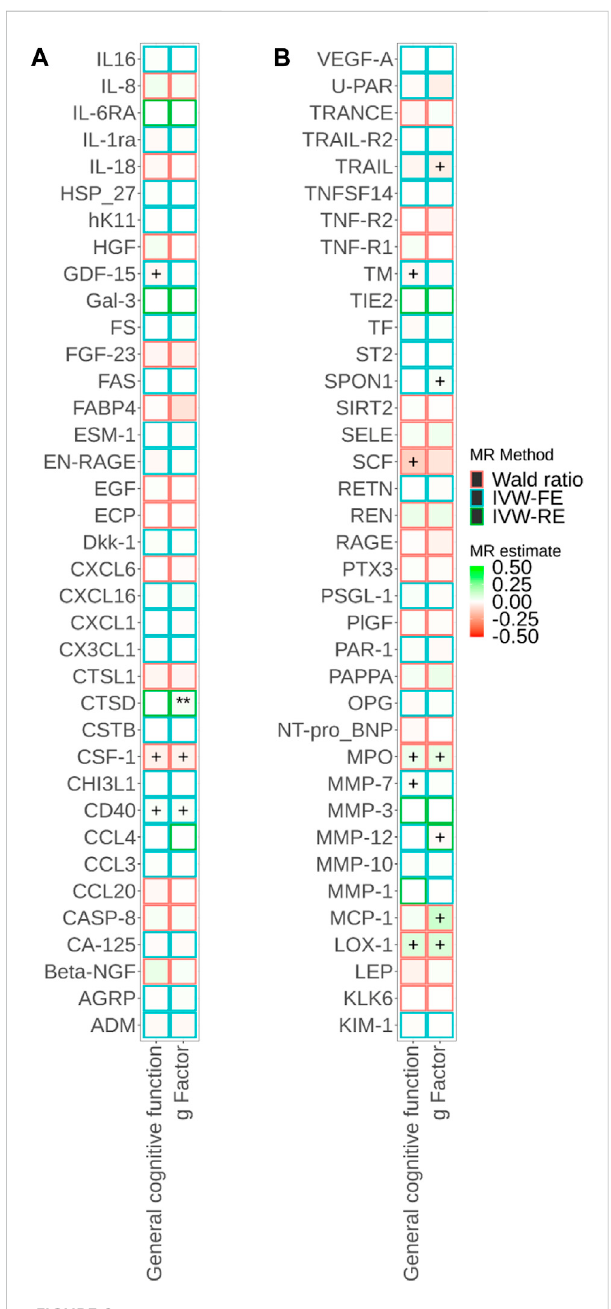
FIGURE 2 Associations of cis-pQTL-predicted plasma protein concentrations with cognitive traits from Mendelian randomisation (MR).MRestimatewasobtainedfromtheWaldratiomethod(N SNP =1) and inverse-variance weighted (IVW) method (N SNP > 1). The symbol+indicatesanassociationwitha p -valuesmallerthan0.05,the symbol *indicates an association with a p -value smaller than 0.05/90, and the symbol ** indicates an association with a p -value smaller than 0.05/180.Dueto thelarge numberofproteins,MRresults fordifferent proteins are presented in Panels a and b in this fi